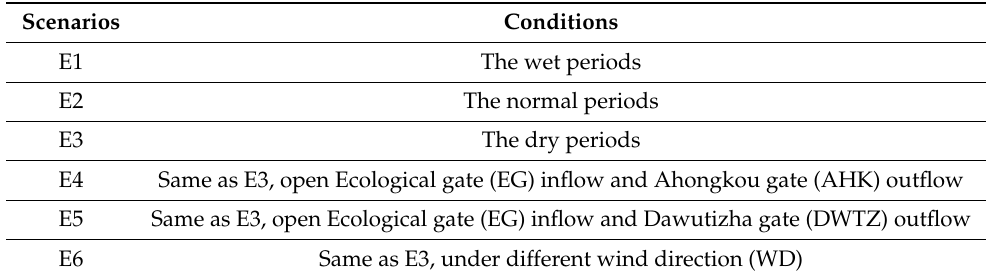
Table 1. The implemented scenarios and their conditions.